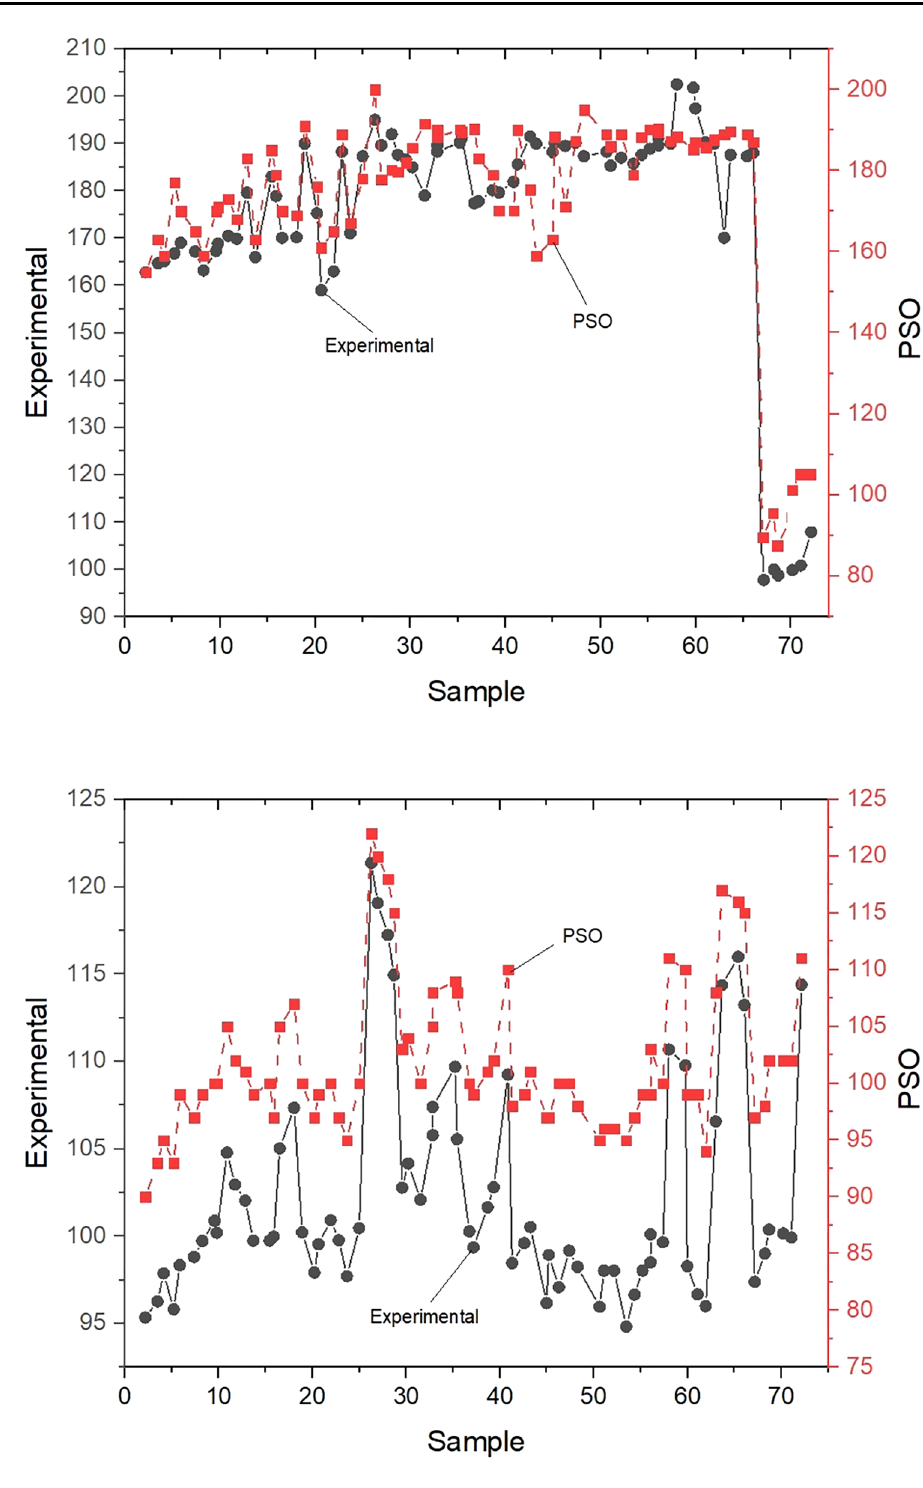
Fig. 11 Comparison between the particle swarm optimiza- tion data and the real data in the tensile test